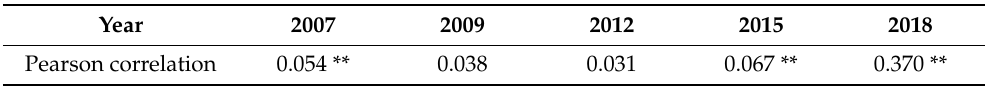
Table 6. The correlation coefficient of elevation and soil organic matter (SOM) content at different